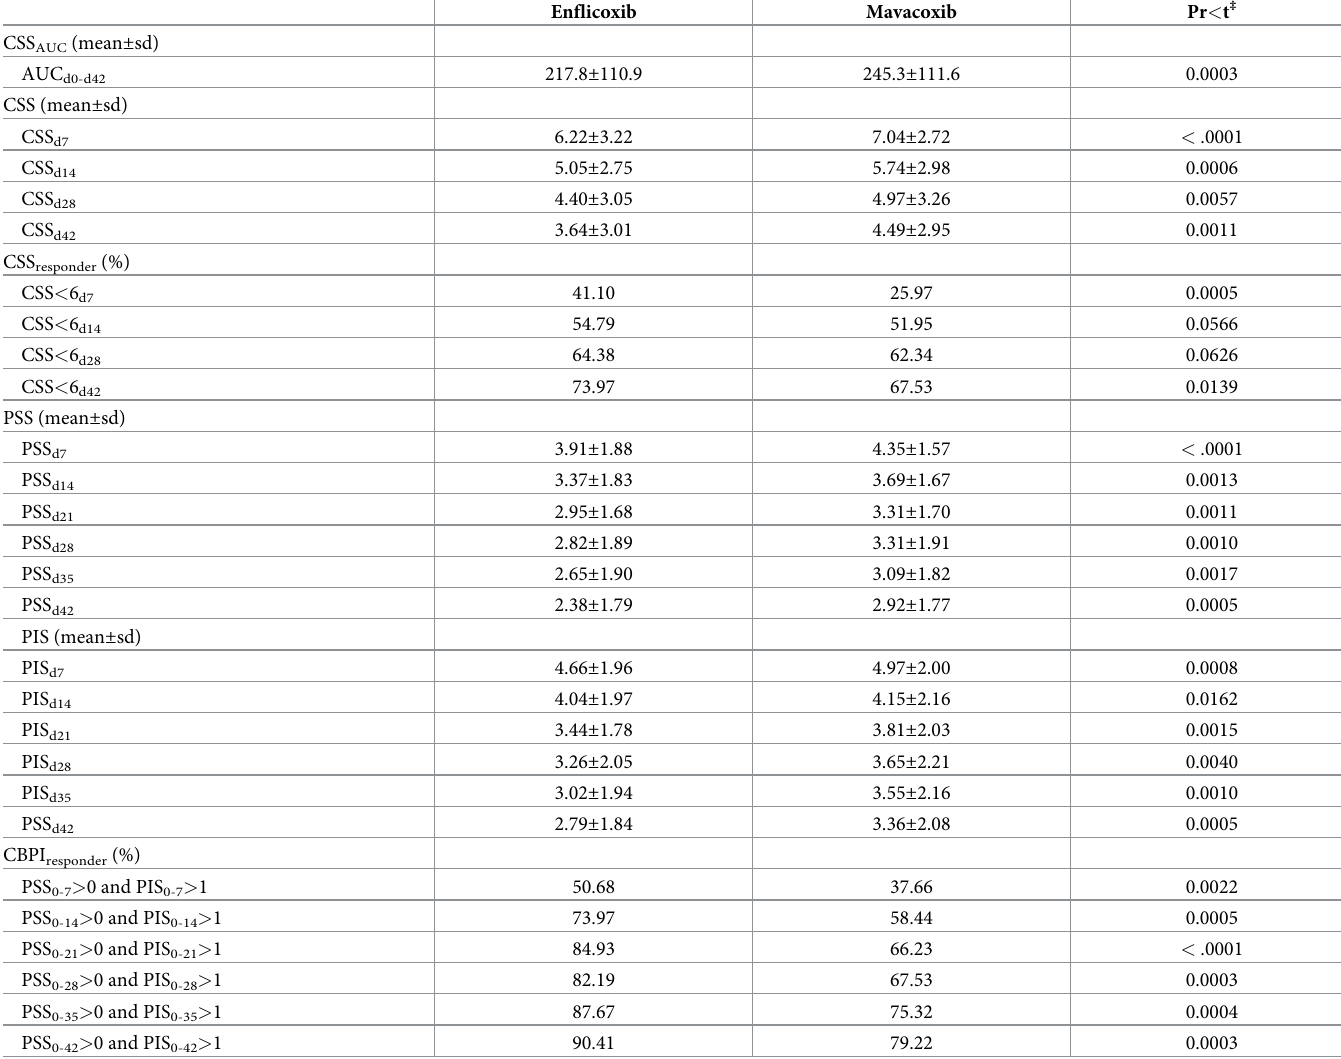
Table 2. Non inferiority analysis for the veterinary assessment: CSS; CSS AUC ; responders’ rate (CSS) and for the owner assessment: PSS, PIS, responders rate